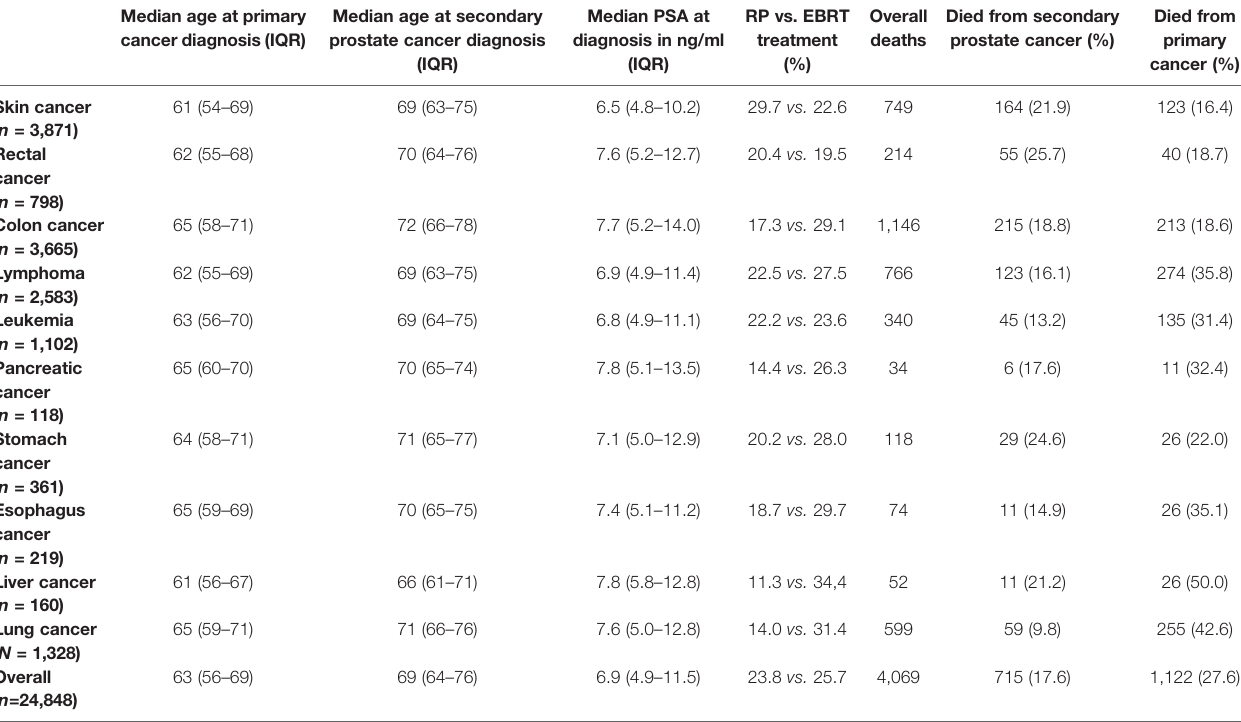
TABLE 2 | Baseline and prostate cancer characteristics of the 10 most common nonurological cancers prior to secondary prostate cancer. Median age at primary cancer diagnosis